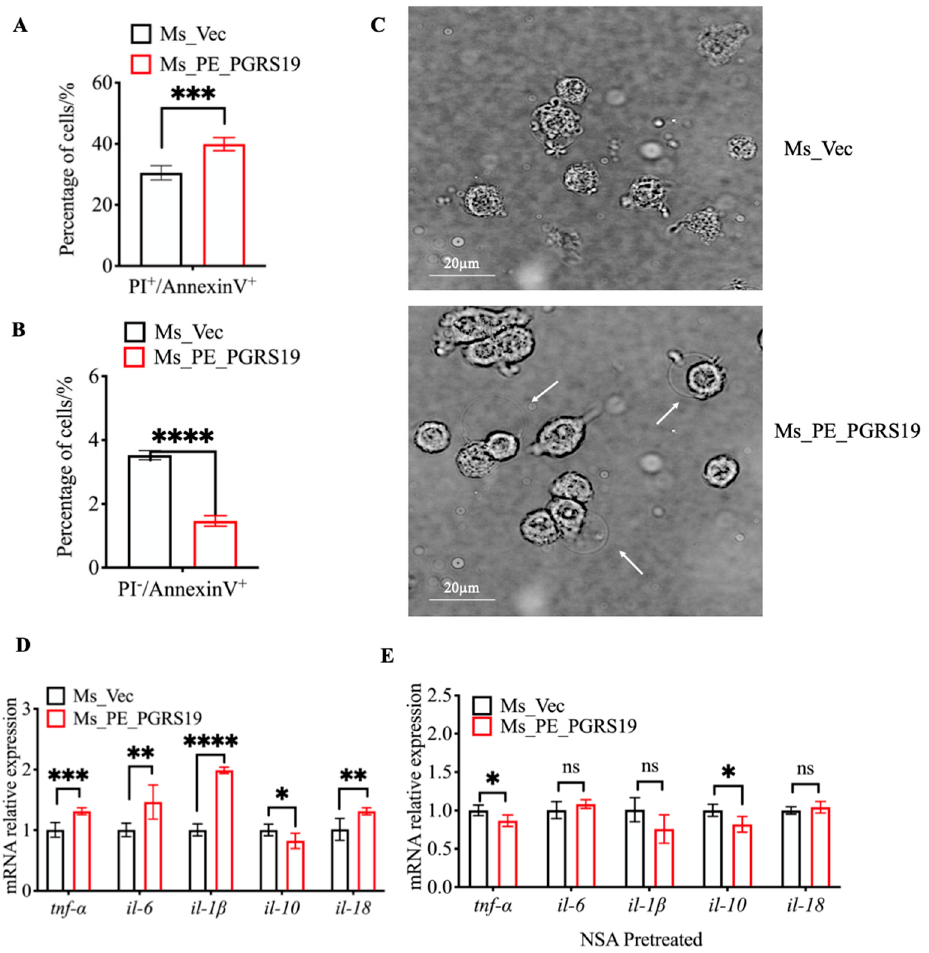
Figure 4. PE_PGRS19 overexpression induced macrophage membrane swelling and pro-inflammation cytokine expression, which were abolished by a pyroptosis inhibitor. J774A.1 cells were infected with Ms_PE_PGRS19 and Ms_Vec for 16 h and stained with annexin V-PI to elucidate the type of cell death. ( A ) PI + /annexin + and ( B ) PI − /annexin + data were analyzed using the FlowJo V10 software. ( C ) Membrane swelling was observed in J774A.1 cells under confocal microscopy after infection with Ms_PE_PGRS19 for 8 h. ( D ) mRNA relative expression levels of il-1 β , il-18 , il-10 , tnf- α and il-6 in J774A.1 cells at 8 h post-infection with Ms_PE_PGRS19 and Ms_Vec. ( E ) mRNA relative expression levels of tnf- α , il-6 , il-1 β and il-18 were measured following pretreatment of macrophages with NSA before infection with Ms_PE_PGRS19 and Ms_Vec for 8 h. Data are presented as x ̄ ± SD of three independent experiments. Multiple t -tests were performed using with Holm–Šídák method. ns p > 0.05, * p < 0.05, ** p < 0.01, *** p < 0.001, **** p < 0.0001.